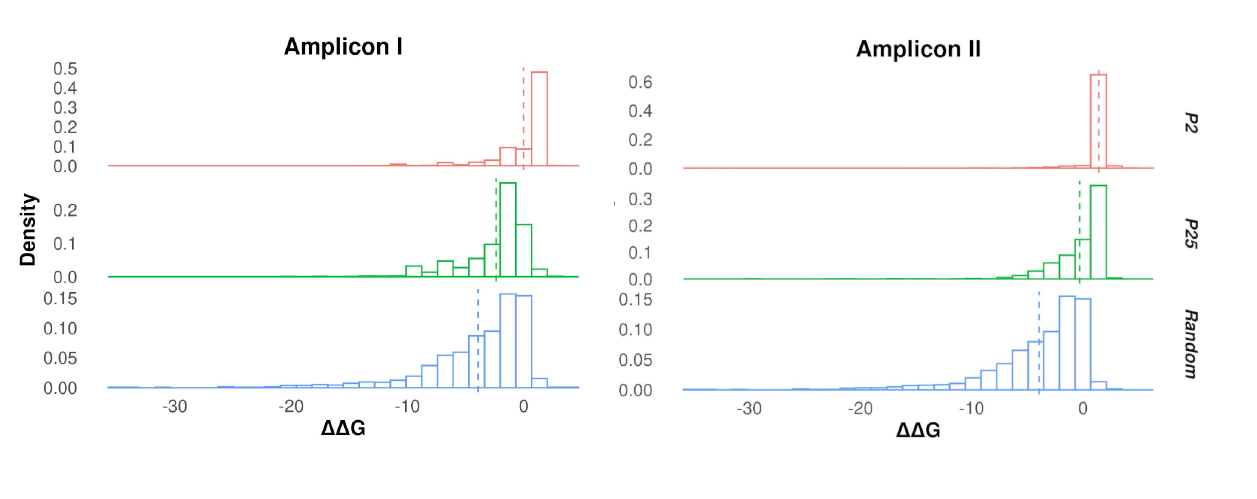
Figure 3. Changes in protein stability for evolved and randomly mutated sequences. The panels show a histogram of changes in folding energy ∆∆ G for the two amplicons studied and three different sets of sequences, as indicated. From top to bottom, the distributions correspond to the evolved populations C43 P2 (P60) (labeled P2 in the y − axis), C43 P25 (P60) (labeled P25), and 1000 sequences with two (on average) amino acid substitutions at random positions. Mean values are indicated with a dashed